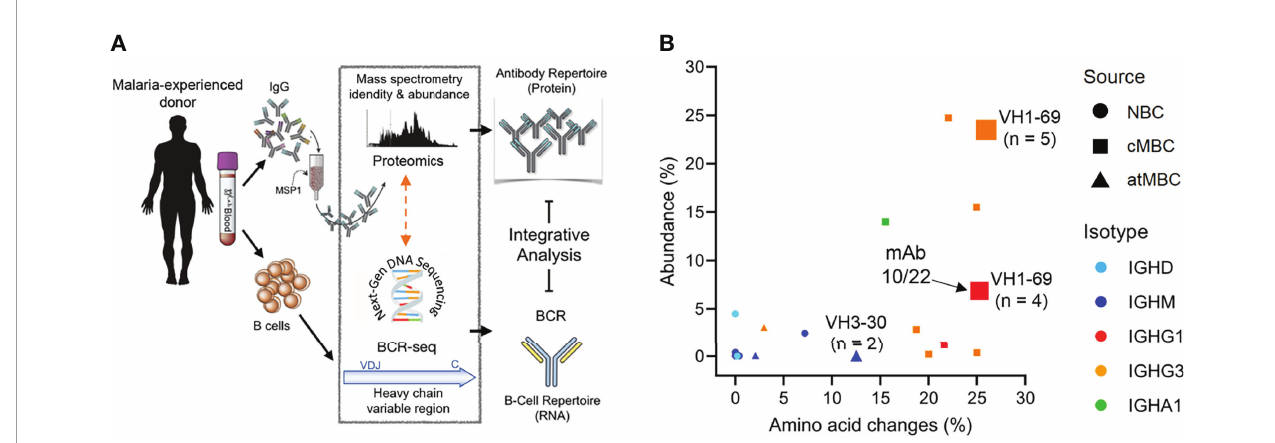
FIGURE 6 | Analysis of the repertoire of anti-PfMSP1 19-3D7 IgG in the plasma of a malaria-experienced adult. (A) Schematic overview of the experimental pipeline. (B) The percentage amino acid changes in the V gene segment of the heavy chain variable region (as determined by B cell receptor sequencing; X axis) plotted against the abundance of the corresponding IgG in plasma (Y axis). The size of the data points indicates the number of clonal sequences found in the B cell receptor sequencing (BCR-seq) data set, as a measure of the size of the clonal B cell lineage. The three lineages that were expanded in the BCR-seq data set are indicated with a number, that represents the number of clonal sequences identi fi ed by BCR-seq. The shape of the data point shows the B cell subset among which the sequence was found (NBC, naïve B cell; cMBC, classical memory B cell; atMBC, atypical memory B cell), while the color indicates the B cell isotype. The data point corresponding to mAb10 and mAb22 (isolated from PfMSP1-speci fi c B cells) is indicated with an